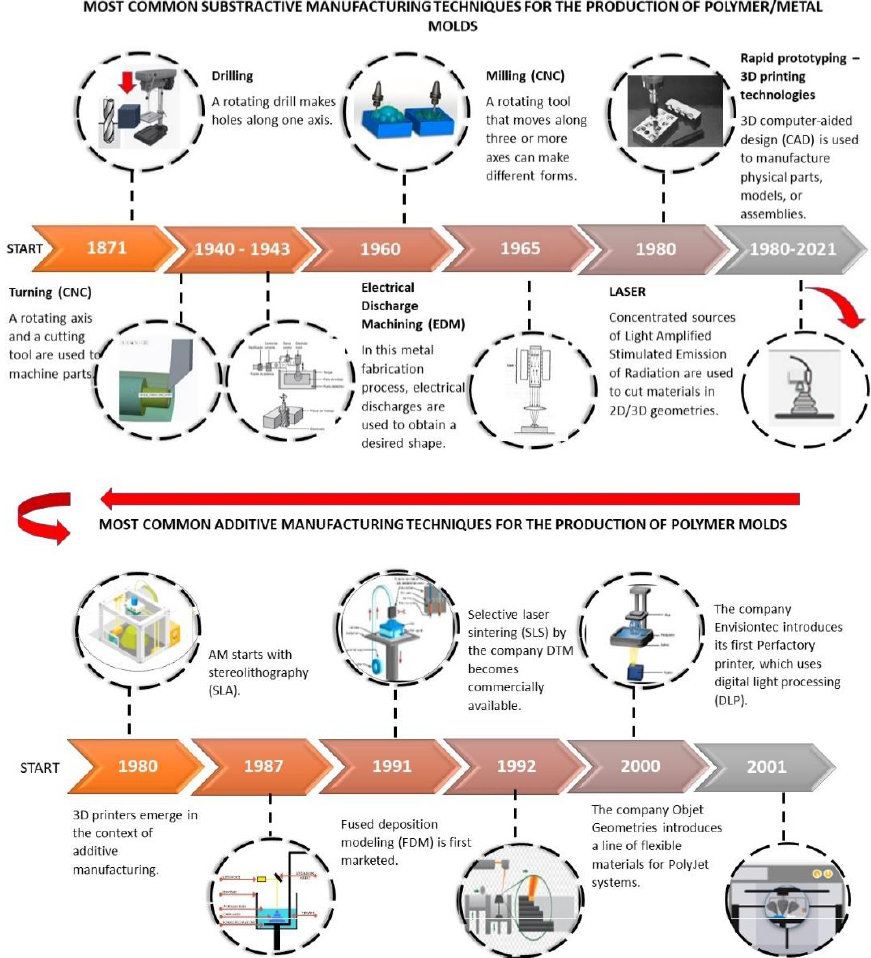
Figure 1. Chronology of the most common subtractive and additive manufacturing techniques for polymer/metal molds.